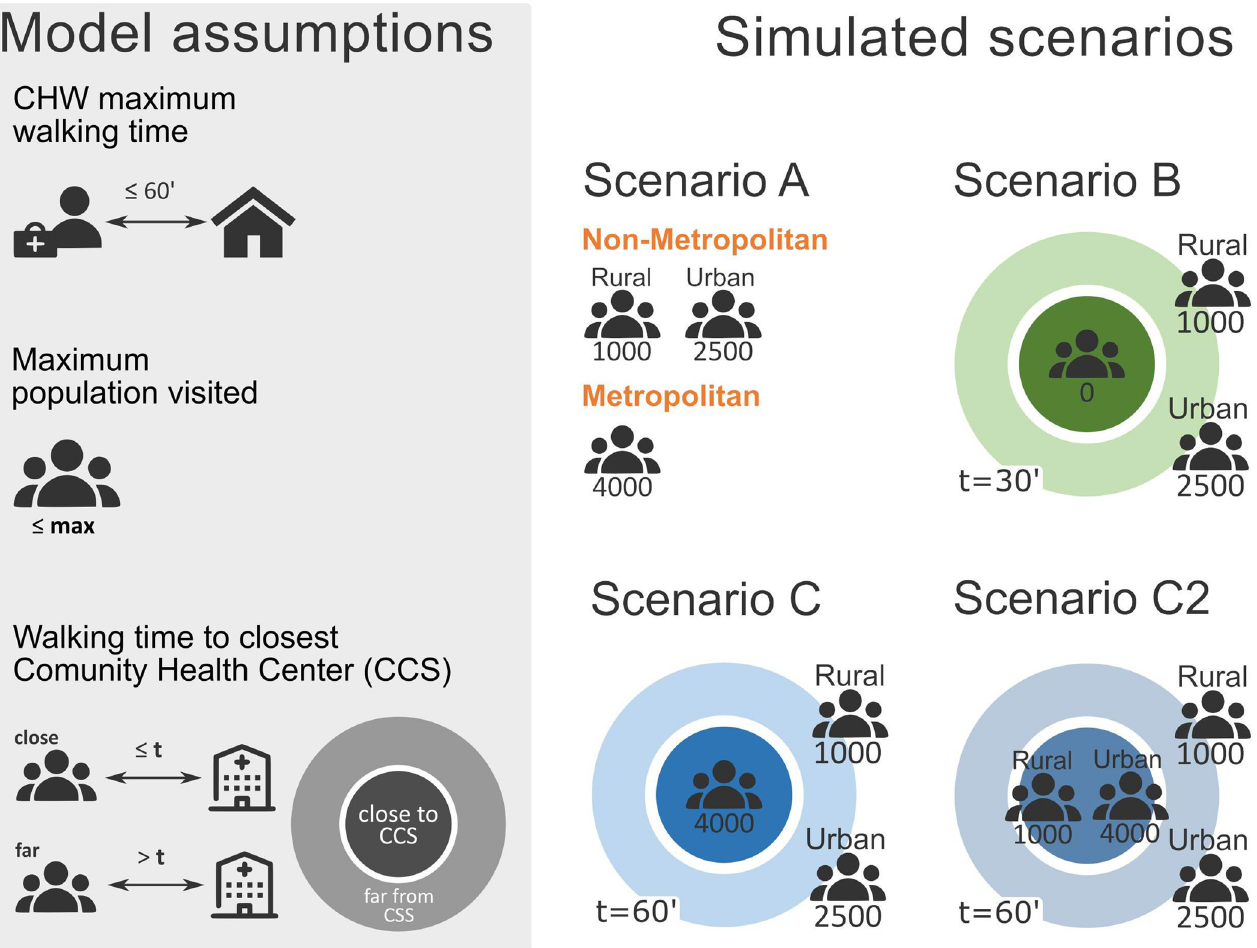
Fig 1. Description of the model assumptions in the four scenarios. The maximum walking time is fixed to 60 minutes. The maximum number of inhabitants per CHW is varied across the four scenarios. In scenario A, the entire territory is covered by CHWs, with a maximum population of 1000 per CHW in rural areas, 2500 in urban areas and 4000 in the metropolitan area. In Scenario B, only areas situated at more than a 30 minutes’ walk from a community health centre (CCS) are covered by CHWs, with a maximum population of 2500 per CHW in urban and metropolitan areas and 1000 in rural areas. In scenarios C and C2, the entire territory is covered by CHWs but the maximum population thresholds depend on the distance to the nearest CCS. In scenario C, less than a 60 minutes’ walk from a CCS, 4000 people are assigned to each CHW and more than a 60 minutes’ walk from a CCS, the maximum populations is 2500 per CHW in urban and metropolitan areas and 1000 in rural areas. Scenario C2 is similar to scenario C, except that the maximum population is 1000 in rural areas, whatever the distance to the closest CCS, and the 4000 threshold within a 60 minutes’ walk from a CCS is applied only for urban